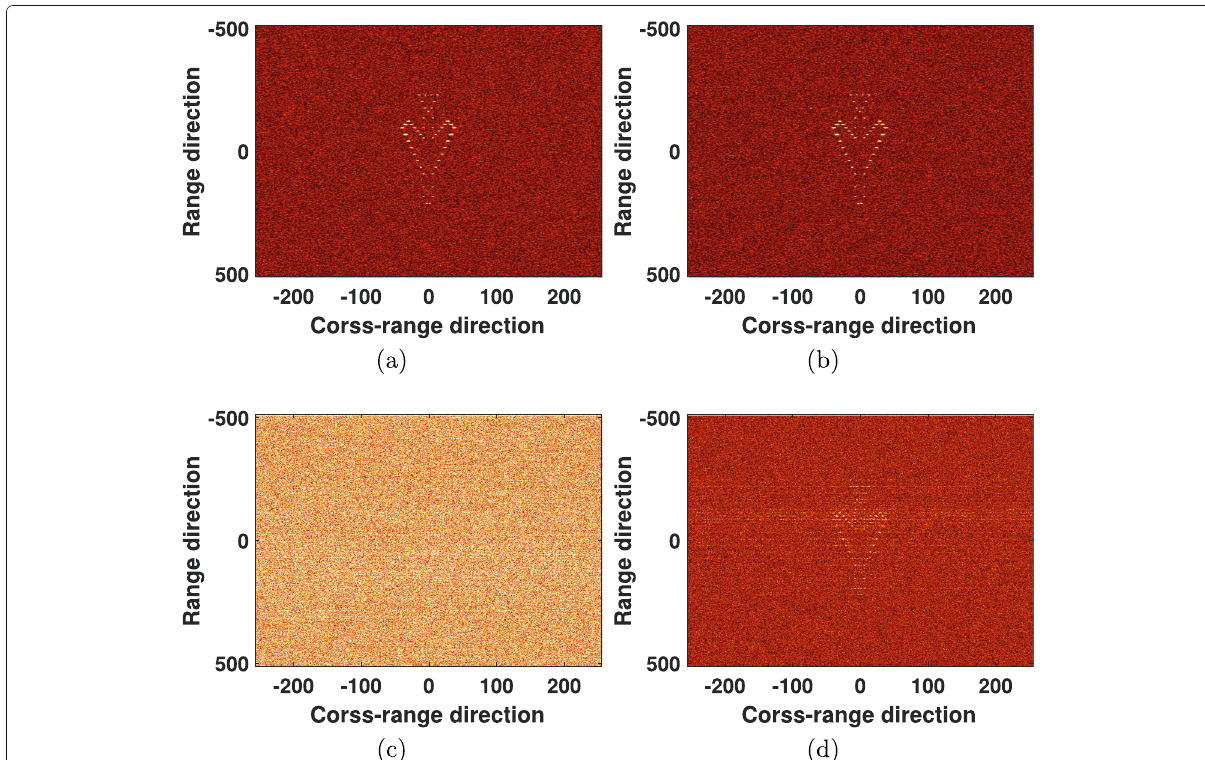
Fig. 7 Imaging results of the different methods under a − 15 dB SNR. a The ideal ISAR image, b the imaging result of the proposed algorithm, c the imaging result of the ACM, and d the imaging result of the MEARP